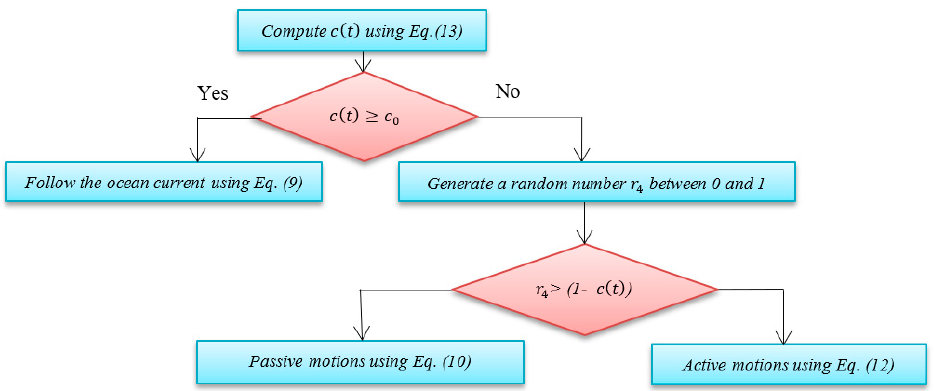
Figure 3. Flowchart of the time control mechanism.